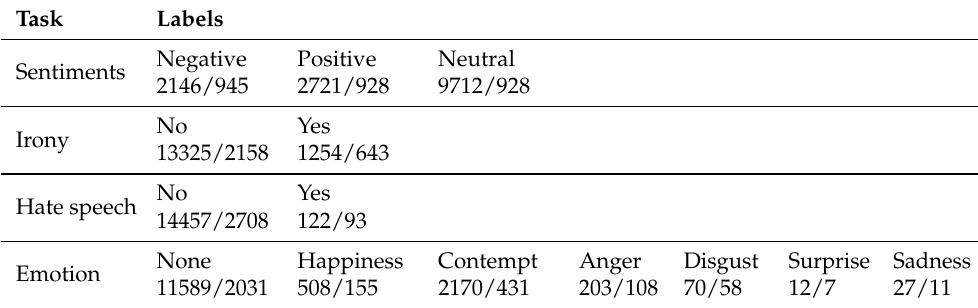
Table 3. Classification task dataset statistics before/after